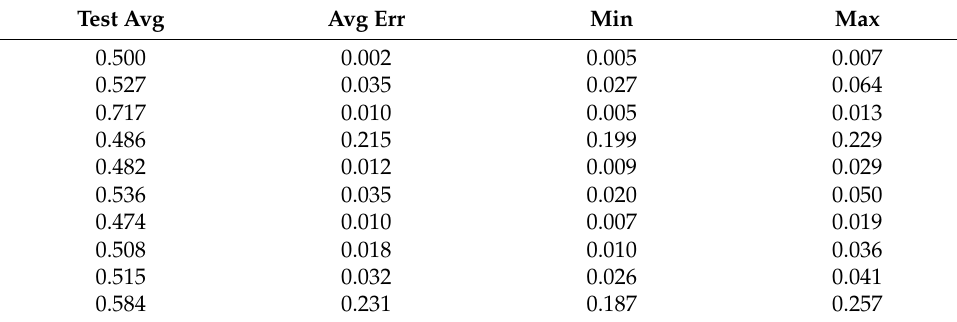
Table A1. Each row’s % err avg is calculated by the corresponding row of Table A5’s